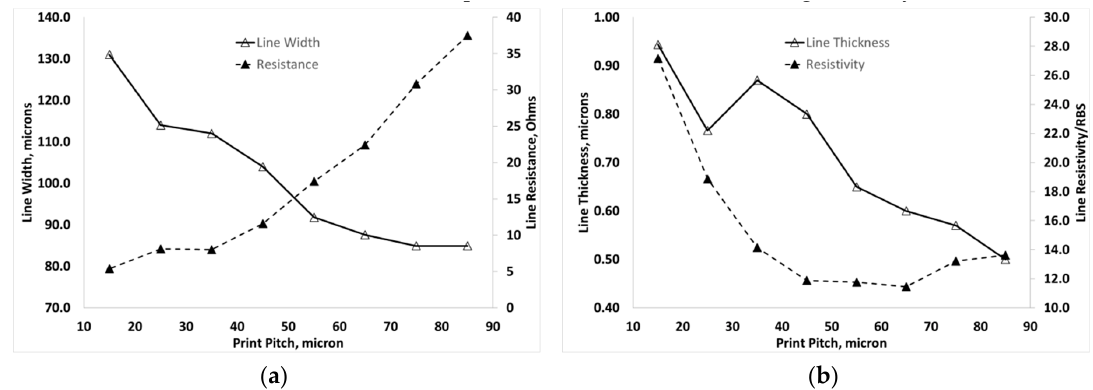
Figure 4. Results from room-temperature printed lines on glossy paper with a 50 µm nozzle diameter ( a ) Effect of print pitch on line width and resistance and ( b ) the effect of print pitch on line thickness and resistivity shown relative to resistivity of bulk silver (RBS).